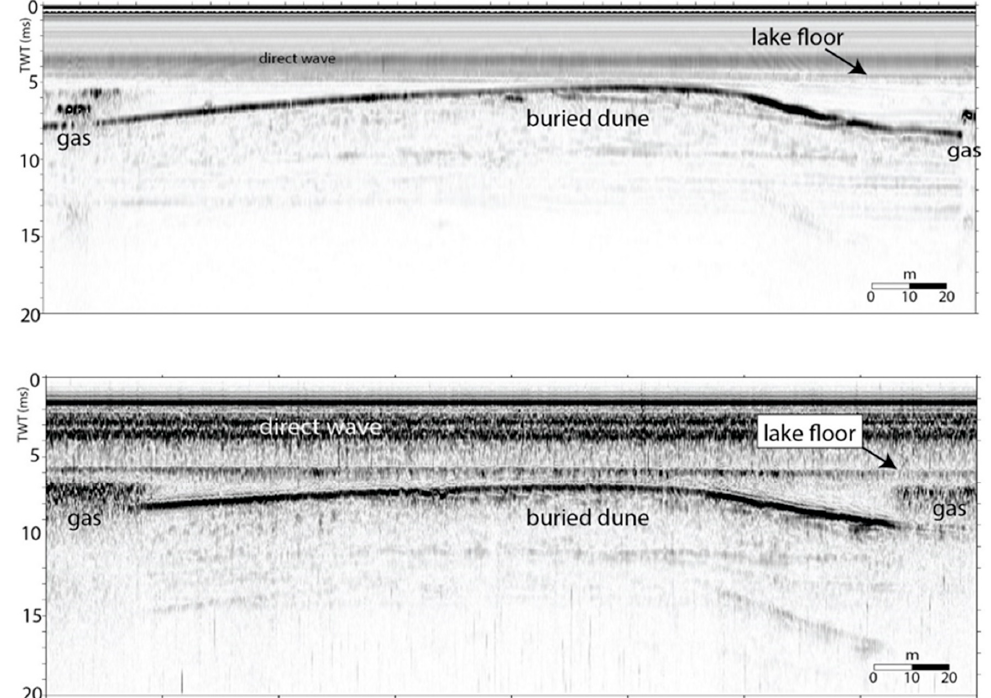
Figure 11. Example of seismic reflection profiles along the same navigation line collected with two different systems in Lake Trasimeno. Top : Chirp III Teledyne-Benthos, with 4 Massa transducers; Bottom : µC HIRP with 4 Monacor transducers. Unconsolidated sediments are penetrated down to 15–20 ms. below the lake floor, by both systems, with high vertical resolutions (tens of cm), enabling a detailed imaging the sedimentary structures.